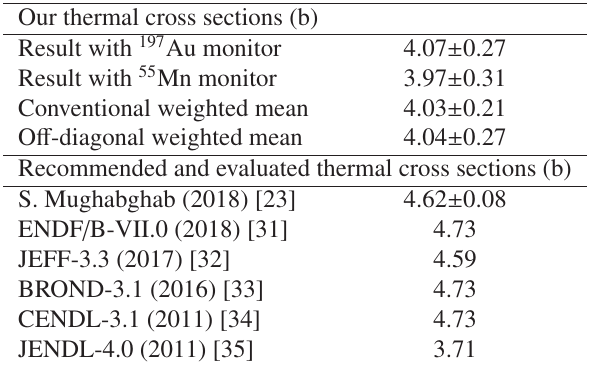
Table 3. Thermal 71 Ga(n, γ ) 72 Ga cross sections from our measurement (revised from Ref. [18]) as well as recommended and evaluated cross sections.